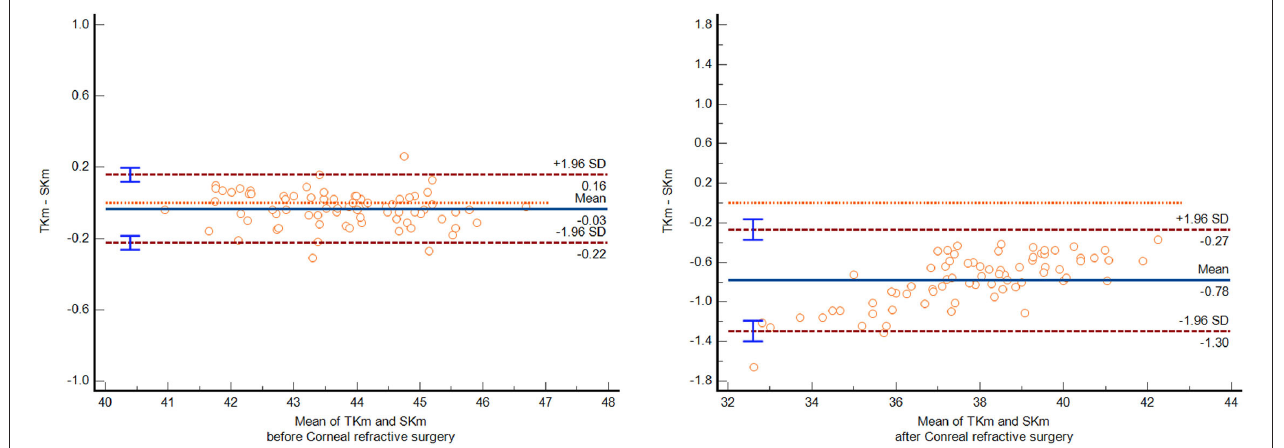
FIGURE 1 | The Bland Altman plot of SK and TK before and after myopic corneal refractive